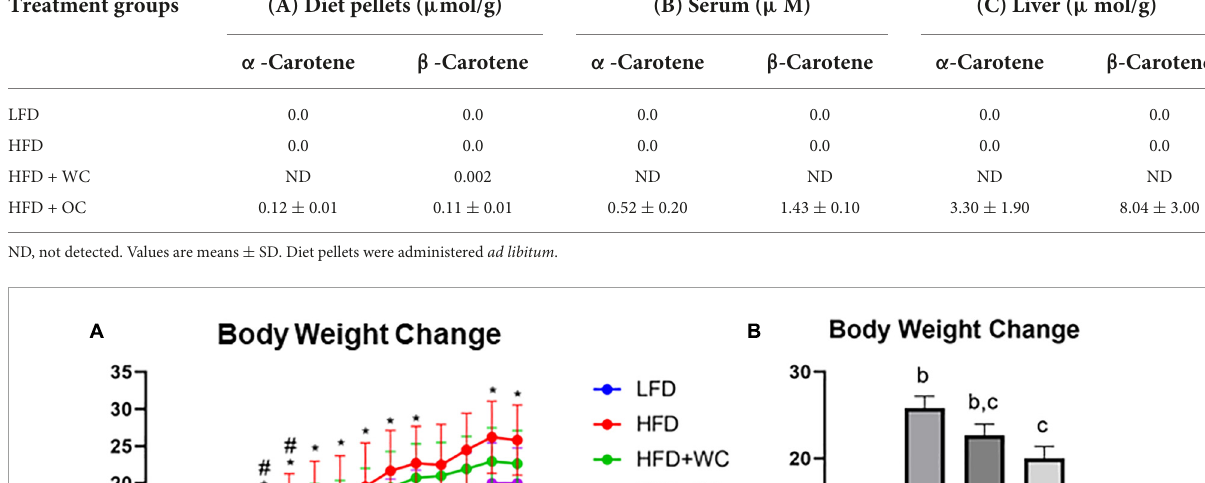
was trending to be lower than HFD + WC, but this difference did not reach statistical significance ( Figure 1C ). The fat mass percentage of total body weight was measured, of which the